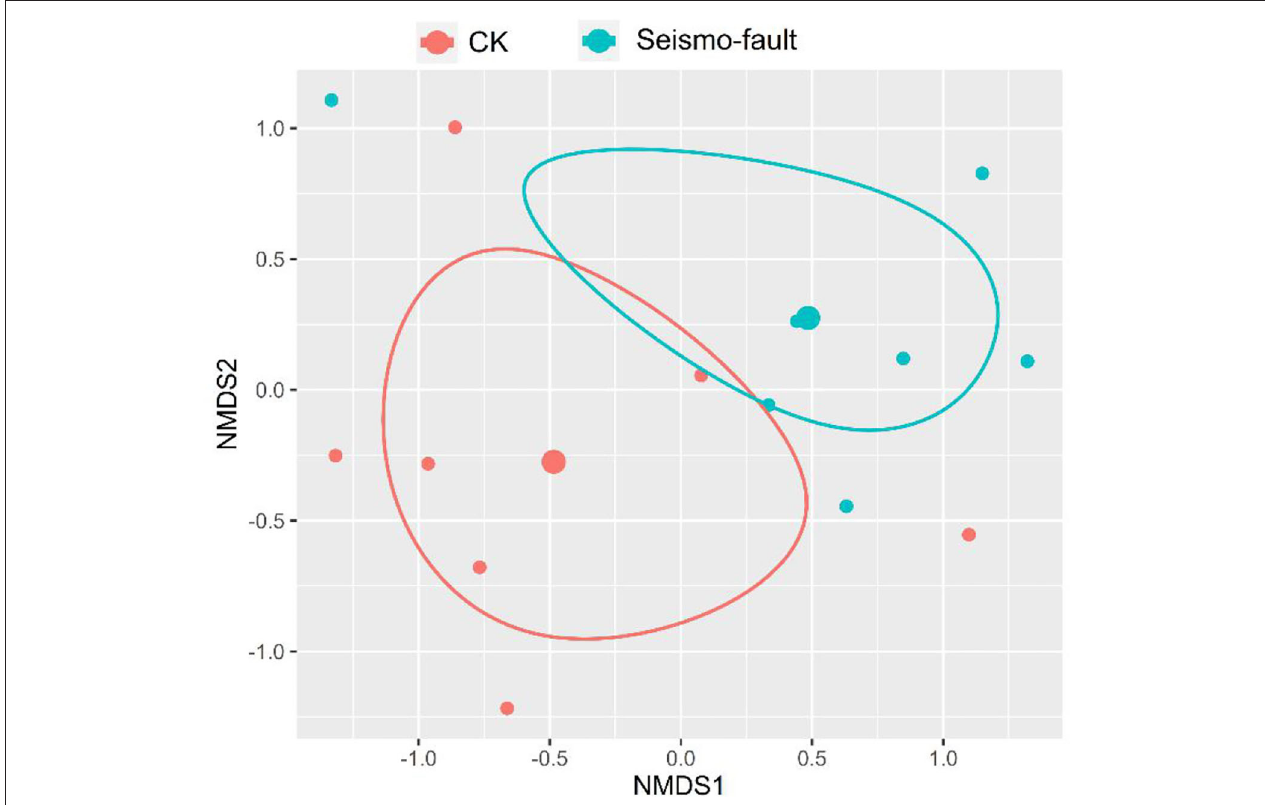
FIGURE 2 | Non-metric multidimensional scaling plot of the species composition between the seismic fracture sites and the control sites. Dots of the same color come from the same group. Each small dot represents a site replication, and each large dot represents the mean value of sites replications. Circles indicate the 95% confidence of the mean